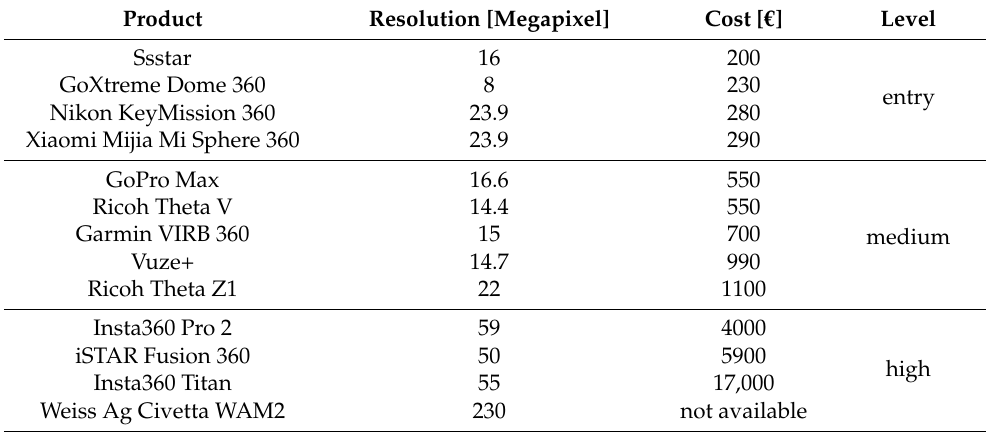
Table 1. Features of typical commercial 360 ◦